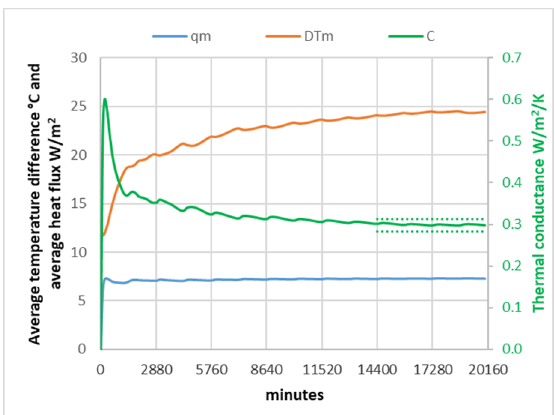
Figure 20. Pre-assembled prototype: average heat flux, average surface temperature difference, and average thermal conductance C.